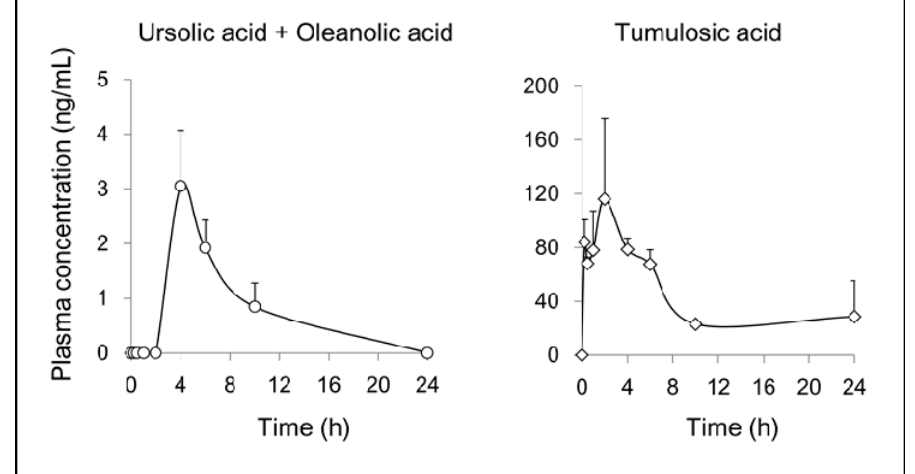
Figure 5. Plasma pharmacokinetic analysis of active triterpenoids of Jumihaidokuto. Plasma samples of rats were obtained at 0.25, 0.5, 1, 2, 4, 6, 10 and 24 h after single oral administration of Jumihaidokuto (JHT) (2 g/10 mL/kg, p.o.). Ursolic acid (and/or oleanolic acid) and tumulosic acid in the plasma were measured by LC-MS/MS. Each data point represented the mean ± SEM of triplicate results.